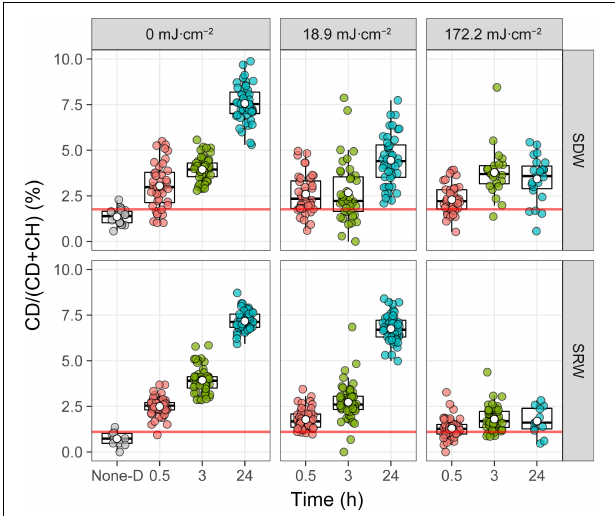
FIGURE 6 | Intensity of deuterium incorporation in single E. coli measured by %CD. Single-cell spectra are denoted by points, and population quartiles are shown as box plots. The red line is the threshold for considering a cell labeled by D. It is determined by the upper quantile of boxplot from the bacterial sample without incubation with D 2 O (None-D indicated in the x